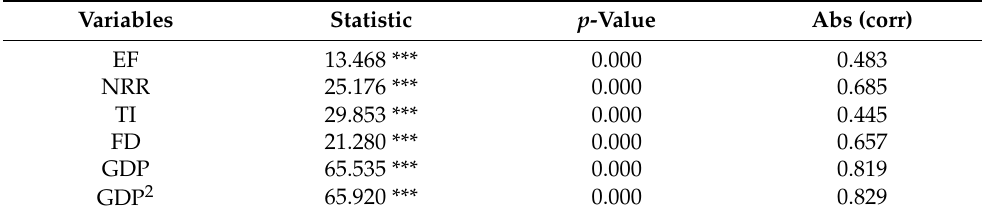
Table 1. Cross-sectional dependence test results of BRI economies.